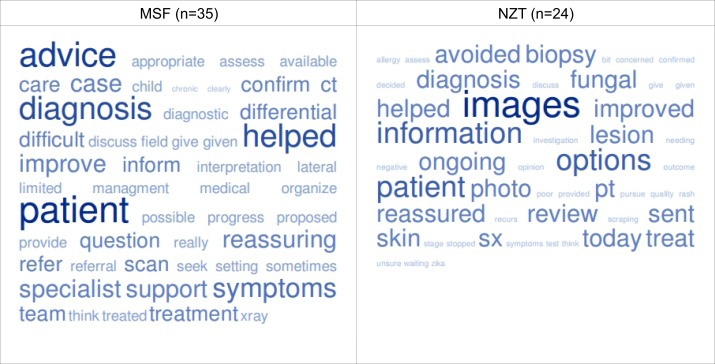
Word frequencies* in the free-text responses to the invitation to comment about why the advice was helpful in the case being followed up. *See http://tagcrowd.com/.